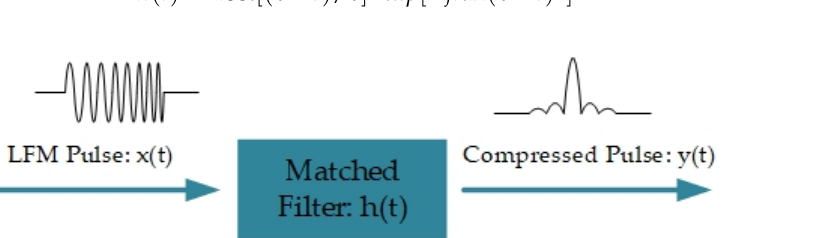
Figure 12. Pulse compression principle with linear frequency modulation (LFM, or FSP) and matched filter.